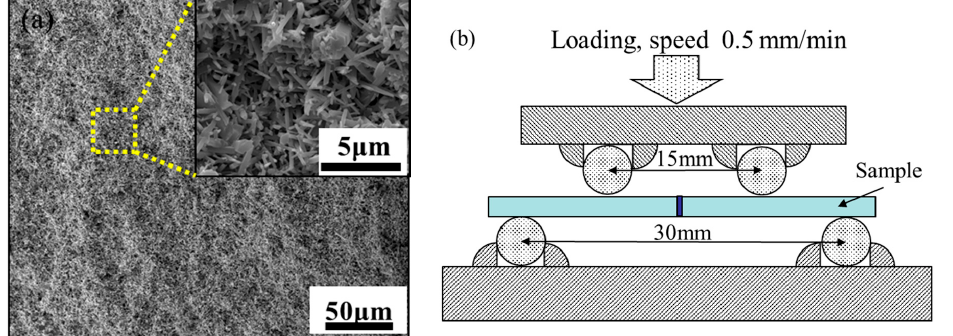
Figure 1. Characterization of the porous Si 3 N 4 ceramic ( a ) and test jig geometry used for four-point bend testing ( b ). bend testing ( b